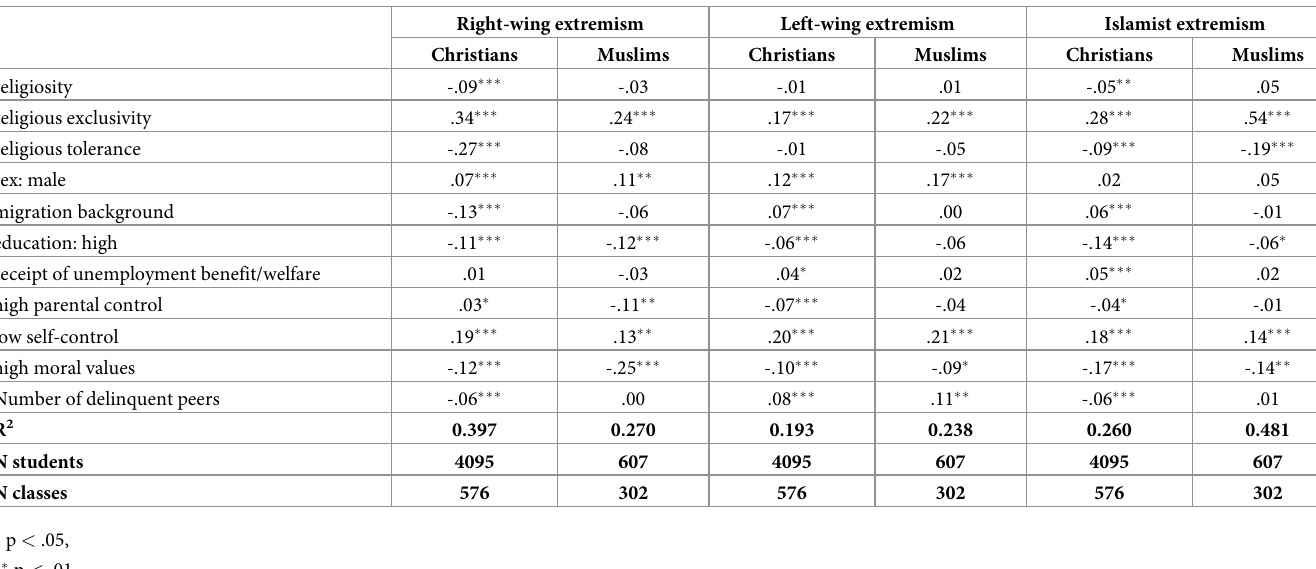
Table 4. Multilevel linear regression of religiosity and religious attitudes on extremism attitude scales (standardised coefficients shown; estimator MLR). Right-wing